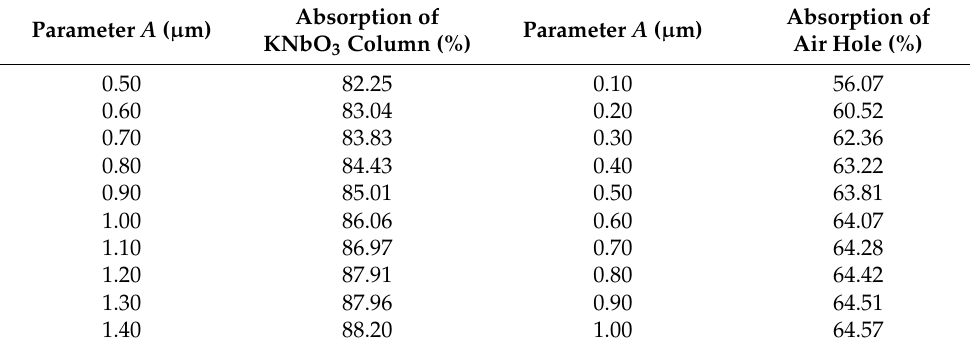
Table 3. The relationship between absorption efficiency of absorption layers with two different hexagonal scatterers and A .